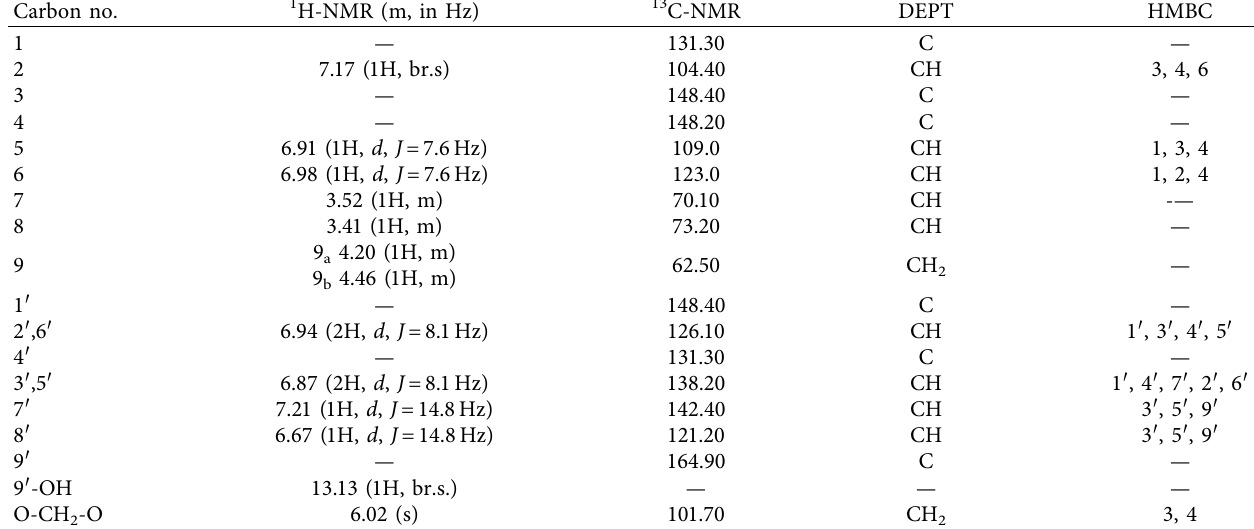
6 ) data of compound (9) .